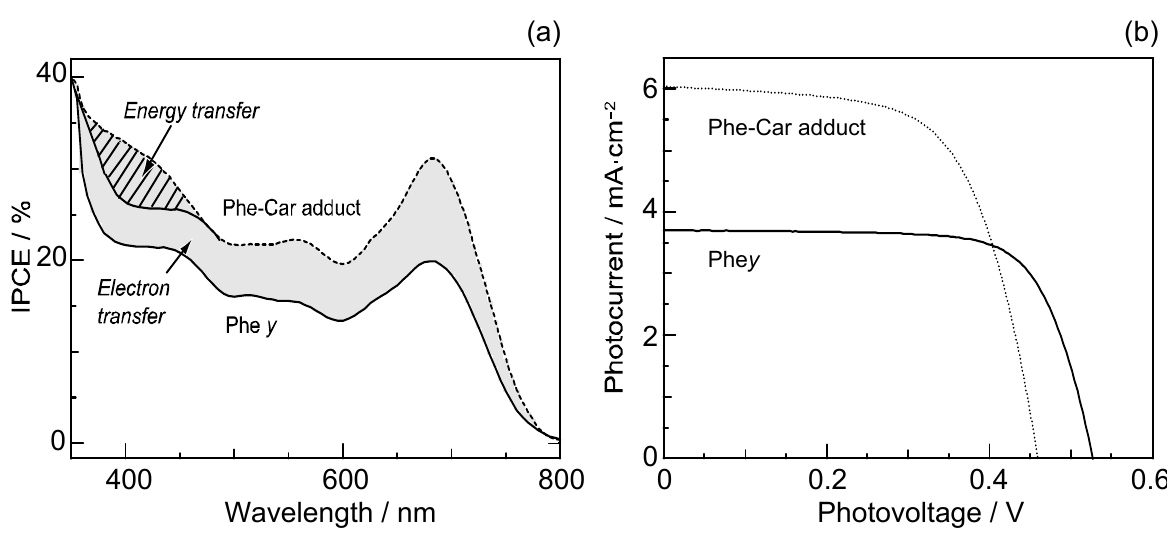
Figure 17. ( a ) The IPCE profiles and ( b ) the I–V curves of solar cells sensitized by Phe y and Phe–Car adduct (reprinted from [9] with permission of Elsevier).